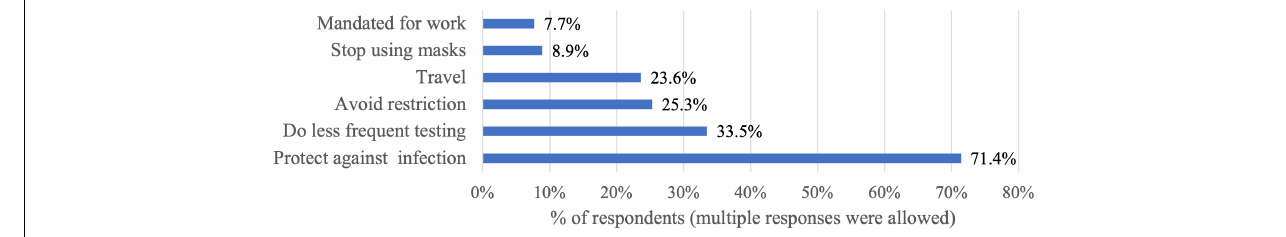
FIGURE 3 | The motivators to get COVID-19 vaccination ( n = 1931).